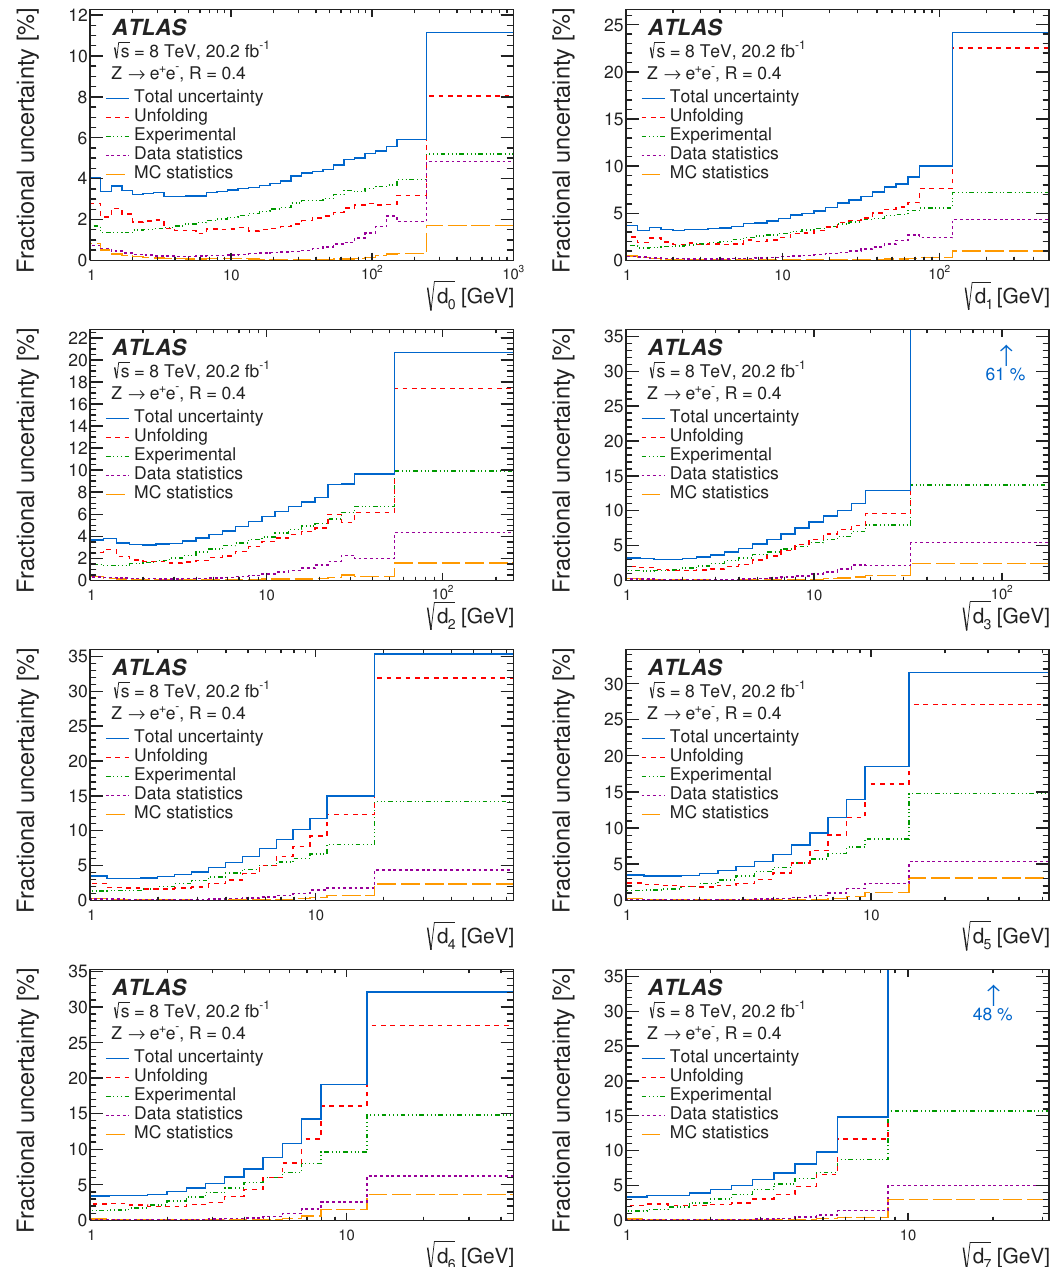
Figure 3. Breakdowns of the total systematic uncertainty into its contributions in the electron channel using the jet-radius parameter R = 0 : 4. The total uncertainty shown is the full quadrature sum of all the individual statistical and systematic uncertainty components, including a constant (cid:6) 1 : 9 % uncertainty in the luminosity